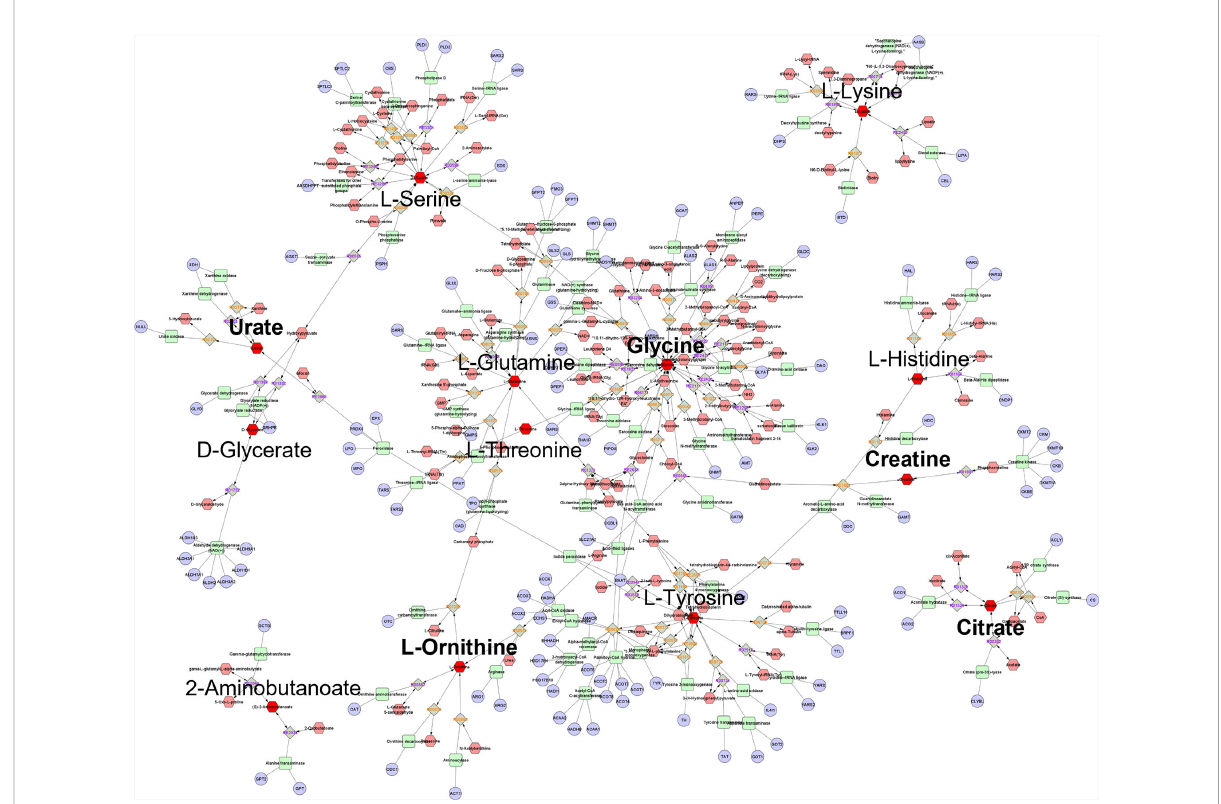
FIGURE 4 Global metabolic network pathways identi fi ed with top ranking IPFD model metabolites. Nodes correspond to an identi fi ed KEGG compound/ gene/reaction, and edges indicate a signi fi cant correlation between nodes. Annotated red hexagons represent input metabolites, pink hexagons represent network metabolites, blue circles represent encoding genes, green quadrangles represent associated enzymes and grey diamonds represent metabolic reactions. Metabolites in bold are hub metabolites by degree and betweenness centrality measures.